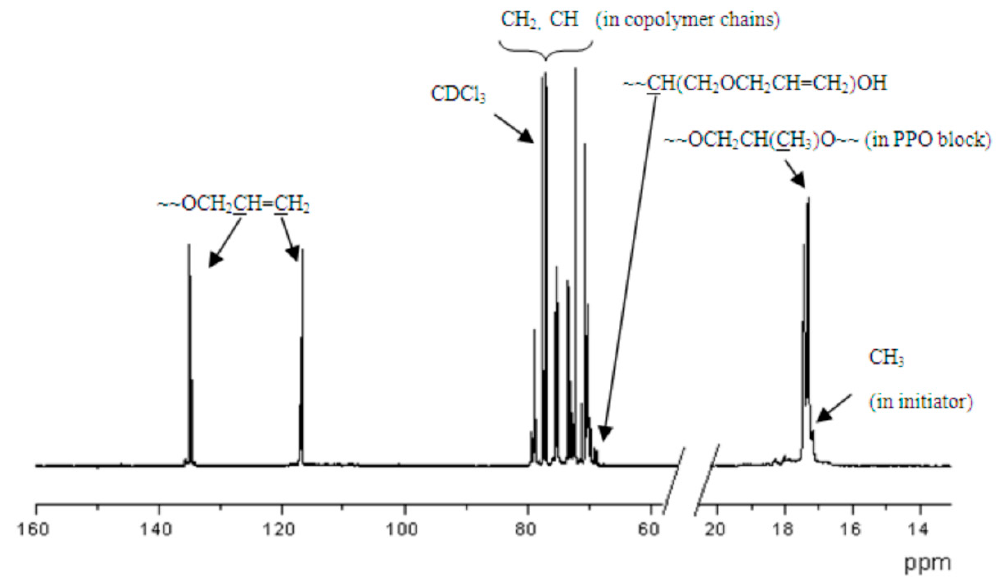
Figure 10. 13 C NMR spectrum of PAGE / PPO / PAGE triblock copolyether-diol (15).